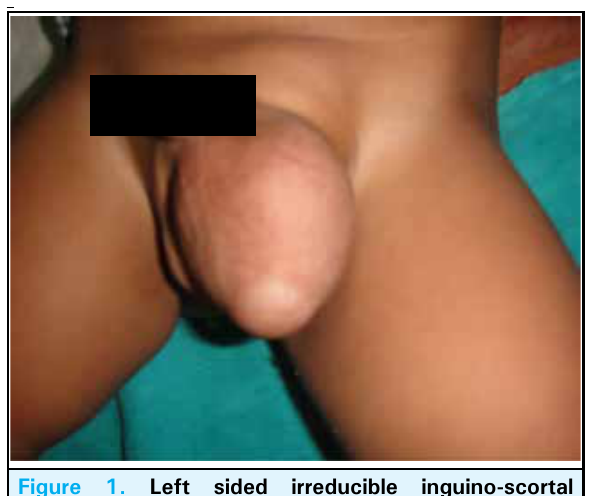
Figure 3. Inflamed